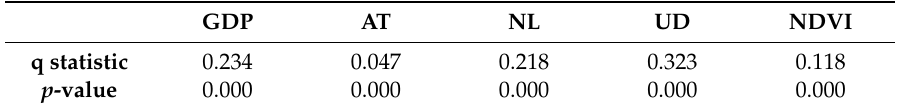
Table 2. The result of factor detectors.